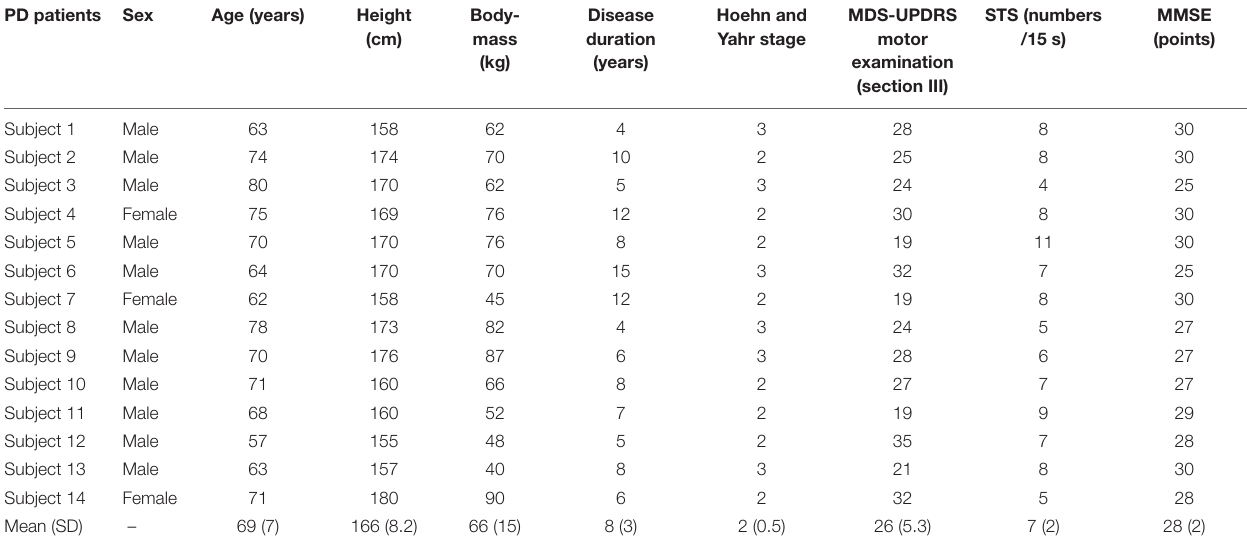
TABLE 1 | Demographic characteristics and clinical parameters of PD patients. PD patients